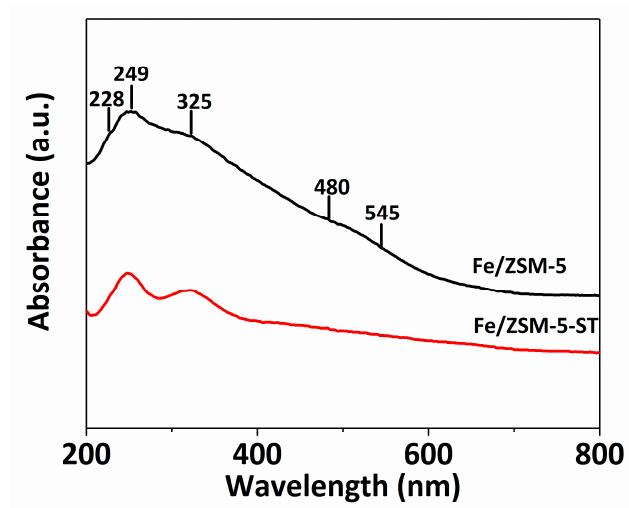
Figure 4. UV-vis spectra of Fe/ZSM-5 and Fe/ZSM-5-ST. Table 2. Percentage of the area of the bands (A 1 at λ < 300 nm, A 2 at 300 < λ < 400 nm and A 3 at λ > 400